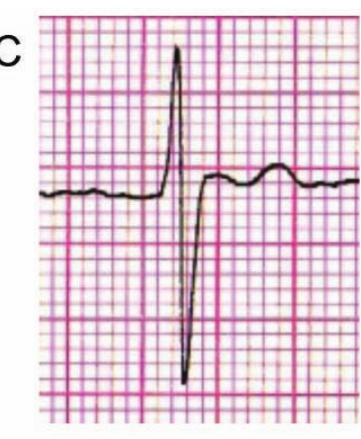
Figure 2. Brugada type electrocardiogram (ECG) patterns. Panel A demonstrates the type 1 Brugada ECG pattern with coved ST segment elevation ≥ 0.2 mV followed by a negative T wave. Panel B shows a type 2 Brugada ECG pattern with saddleback ST segment elevation ≥ 0.2 mV with a trough of ≥ 0.1 mV followed by a positive or biphasic T wave. Panel C demonstrates the type 3 Brugada ECG pattern with either coved or saddleback ST segment elevation of ≤ 0.1 mV.